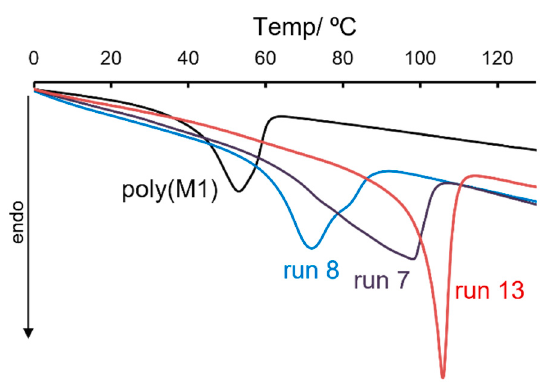
Figure 4. DSC thermograms of hydrogenated poly(M1- co -DCD)s prepared under various M1:DCD molar ratios [M1:DCD = 1:2 (run 8), 1:5 (run 7), 1:10 (run 13)]. Detailed data are shown in Table 1.